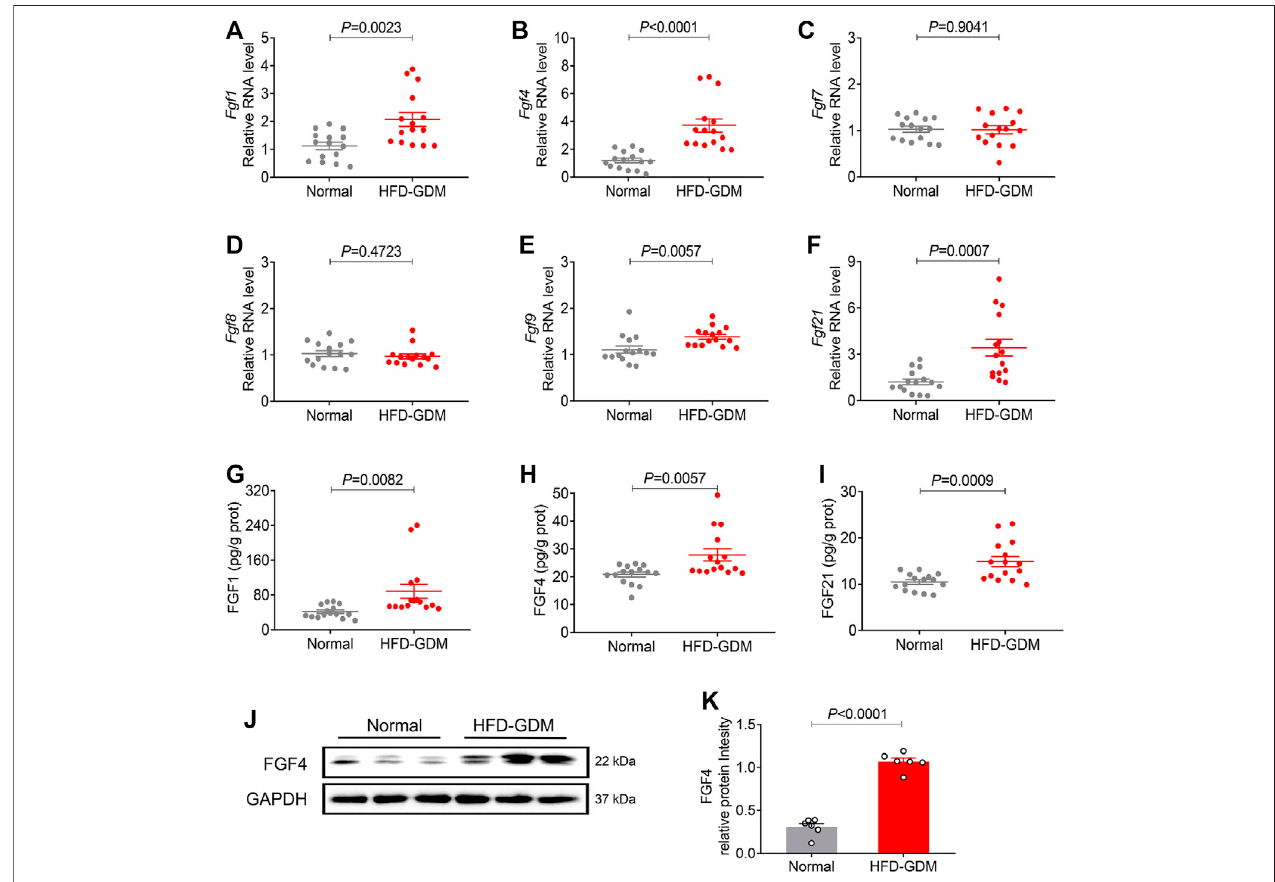
FIGURE2| ThemRNAand proteinexpression ofrepresentativeFGFfamilymembersinplacentasofHFDinducedGDManimalmodels. (A – F) ThemRNAlevelsof Fgf1 , Fgf4 , Fgf7 , Fgf8 , Fgf9 and Fgf21 wereanalyzedusingRT-PCR. (G – I) TheexpressionlevelsofplacentalFGF1,FGF4andFGF21weredetectedusingELISA.These experimentswereperformedusing15placentasfromdifferentmicepergroup.Dataarepresentedasmeanvalues±SEM( n =15). (J) TheFGF4proteinexpressionlevels were detected using western blotting (three placenta from different mice per group), and representative images from two independent experiments were shown. (K) Densitometric quanti fi cation of western blots shown in (J) . Data are presented as mean values ±SEM ( n = 6); a value of p < 0.05 was considered to be statistically signi fi cant.